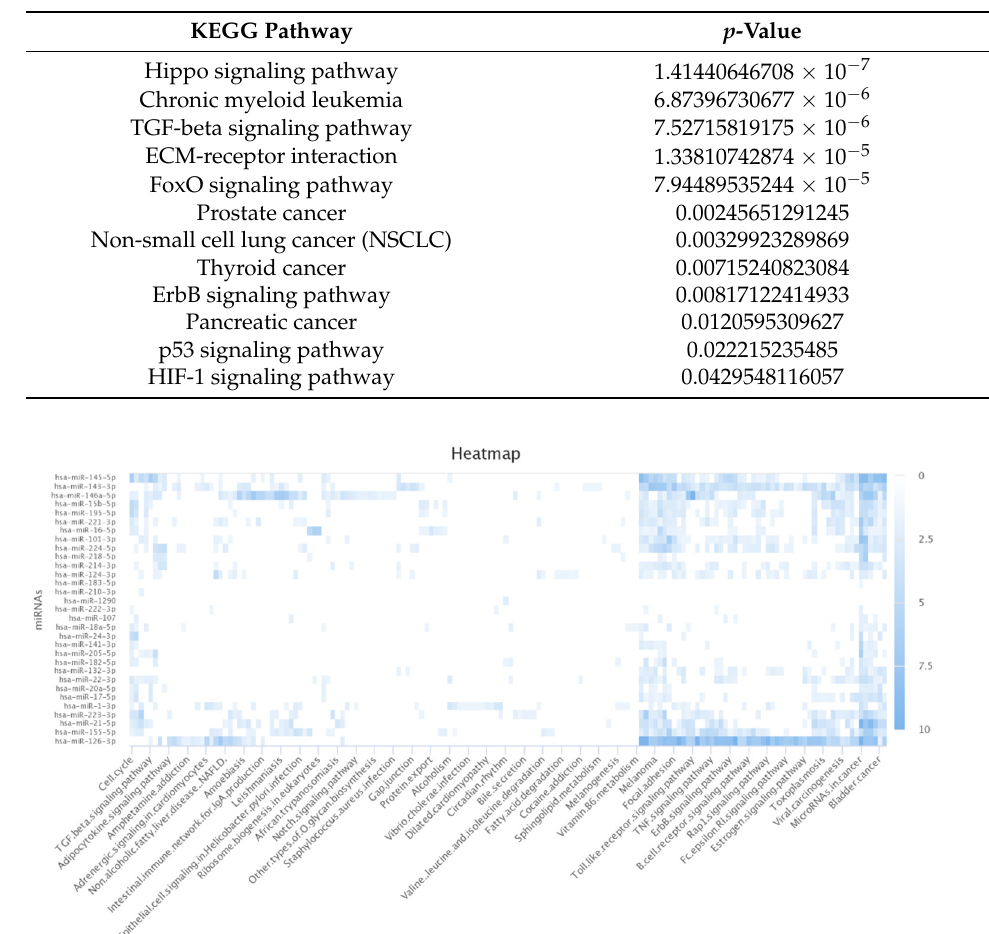
Figure 7. Heatmap of lung cancer-related miRNAs versus target